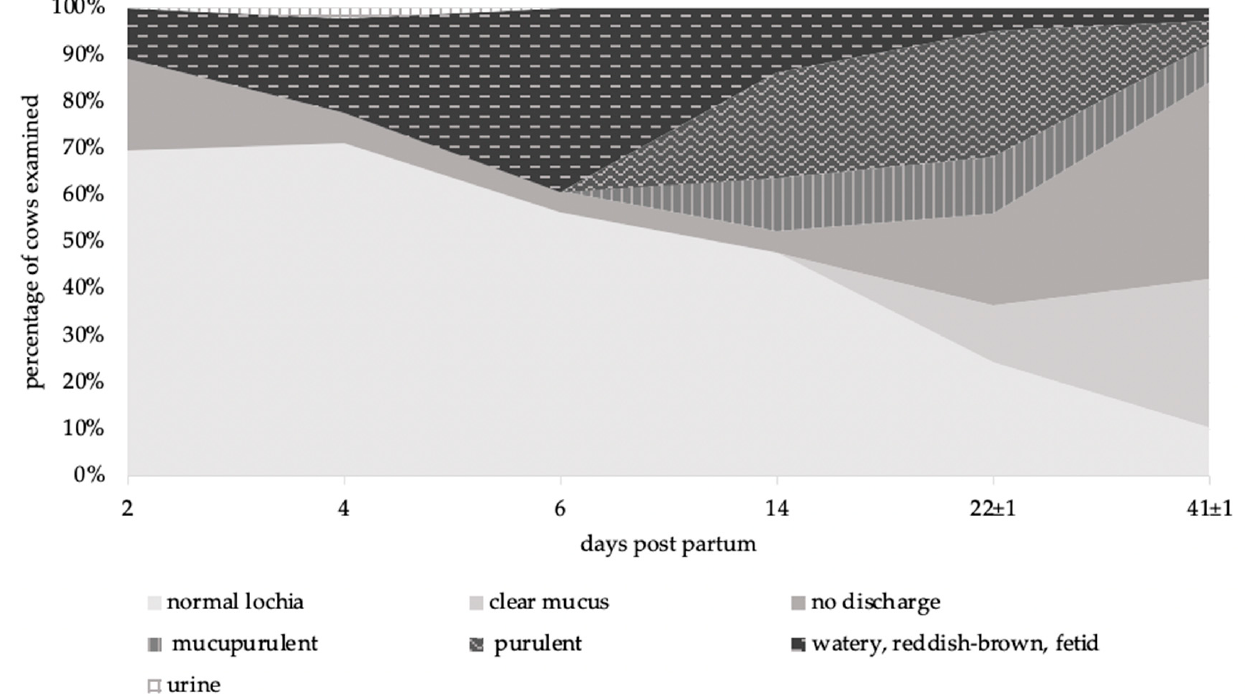
Figure 3. Development of vaginal discharge over the period of puerperium (n = 46).